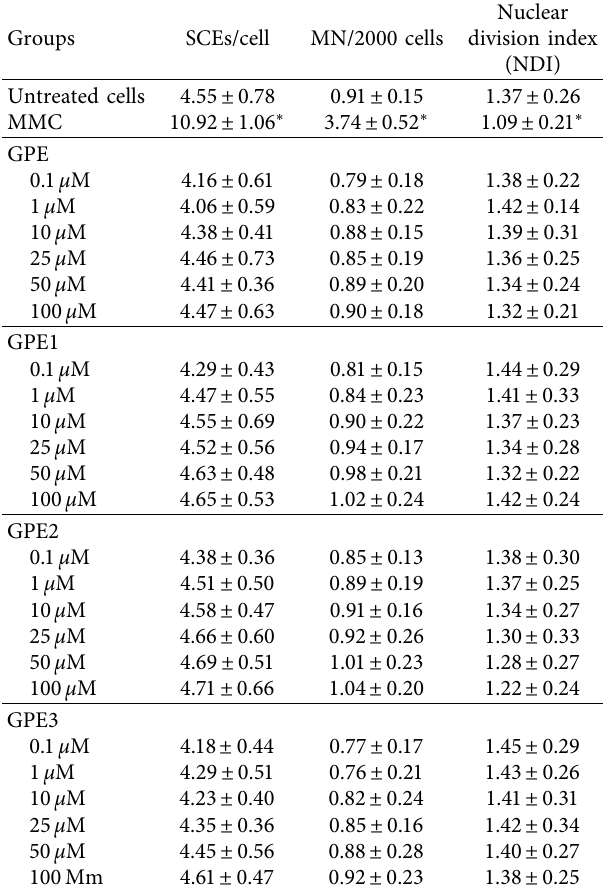
Table 2: Te efects of GPEs on SCE and MN rates in cultured human lymphocytes. ∗ symbol presents a statistical diference from the control (-) group at the level of p < 0 . 05.